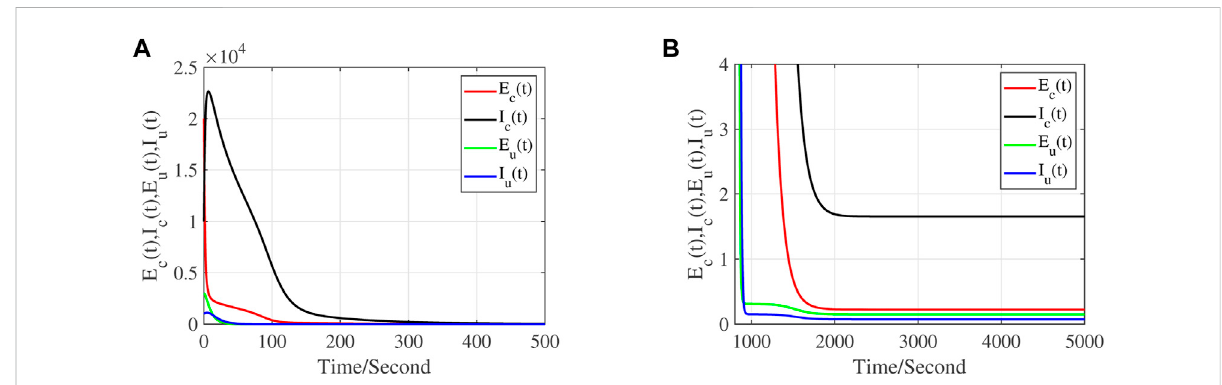
FIGURE 2 Timeseriesplotofsystem(1)with Λ 1 =0.75, Λ 2 =0.1, σ =0.6, ] =0.1, β 1 =0.053, β 2 =0.035, α 1 =0.8, α 2 =0.3, μ 1 =0.01, μ 2 =0.1, τ =0.1, η =0.45, ϵ = 0.25, ϕ = 0.05, p = 0.003, ξ = 0.05, θ = 0.001, γ = 0.05. (A) the tendency of the worm propagation in a short period, (B) the tendency of the worm propagation in a later